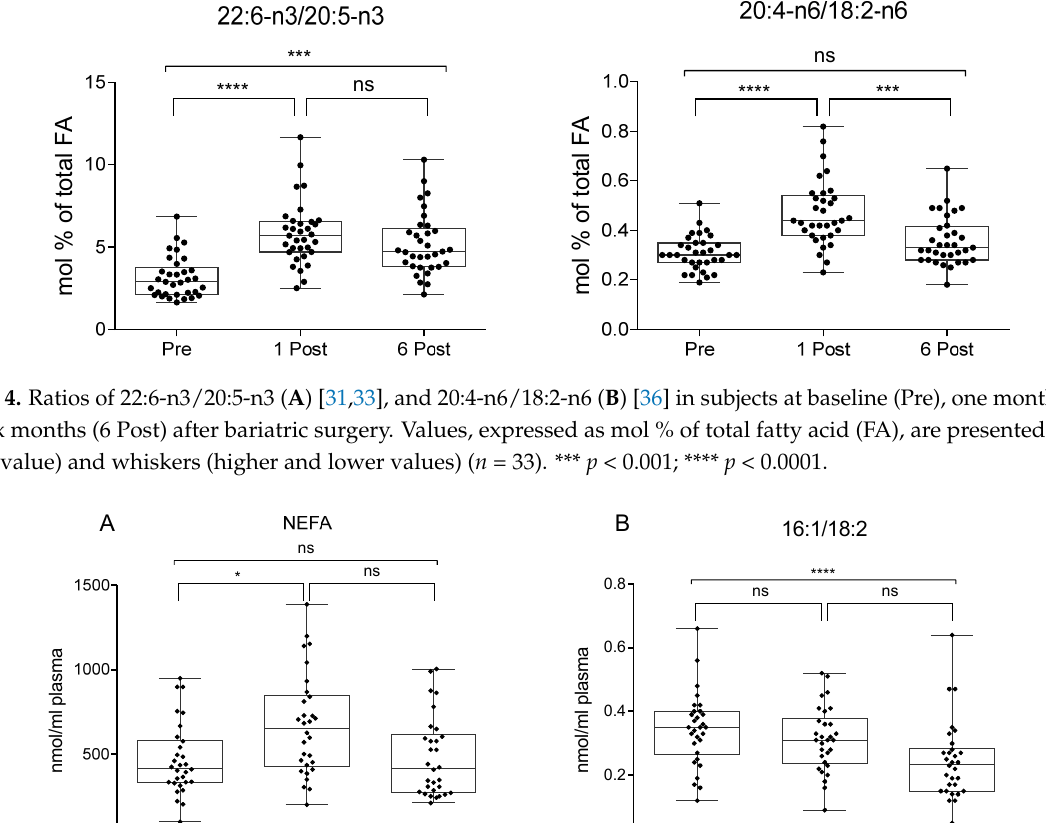
Figure 5. Values of non-esterified fatty acid (NEFA) ( A ) and 16:1/18:2 ( B ) [30] expressed as nmol/mL of plasma in participants at baseline (Pre), one month (1 Post) and six months (6 Post) after bariatric surgery. Values are presented as boxes (mean value) and whiskers (higher and lower values) ( n = 30). * p < 0.05; **** p < 0.0001.